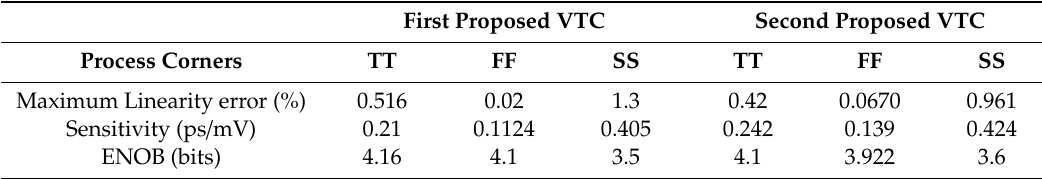
Table 2. Performance of the proposed VTCs at process corners before calibration.